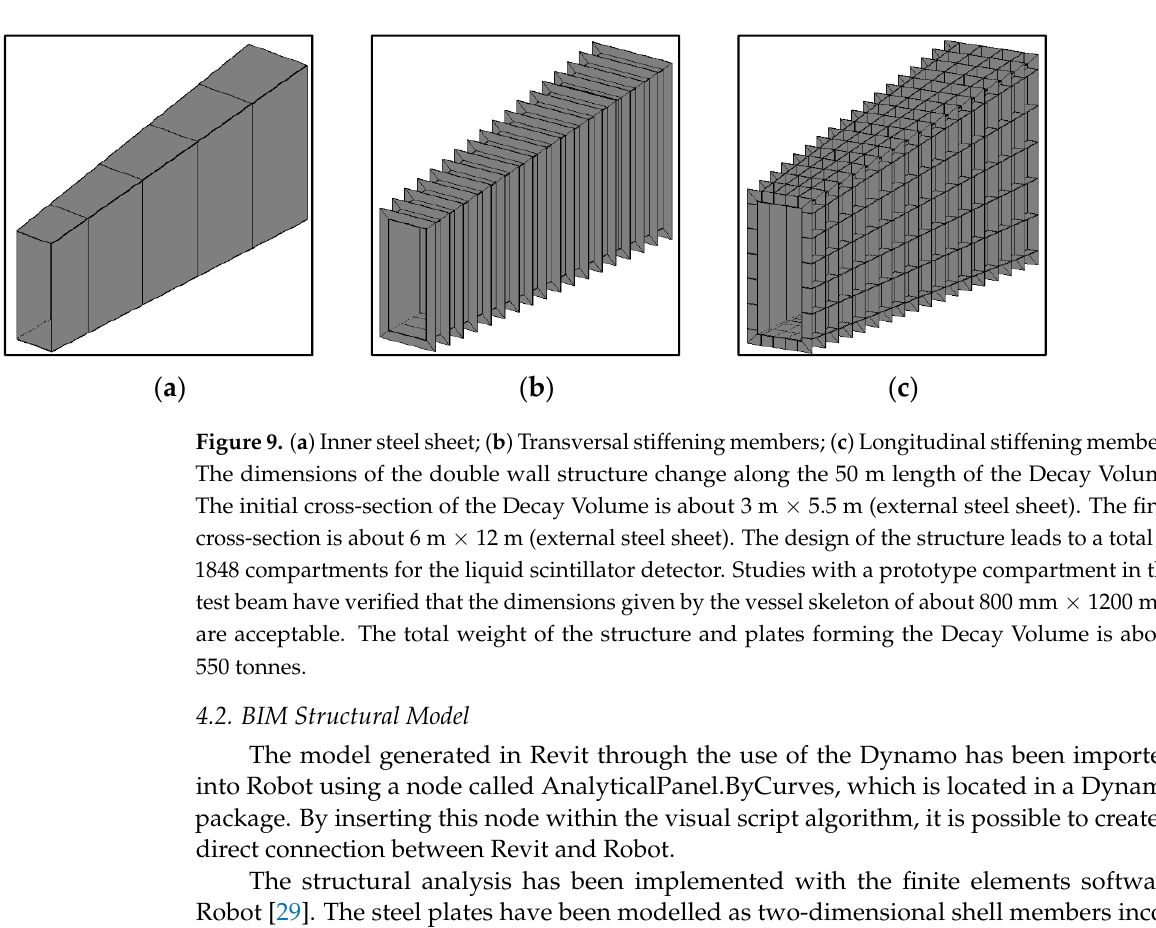
( a ) ( b ) Figure 11. External steel sheet stress path: ( a ) UC σ x; ( b ) UC σ y. ( a ) ( b ) Figure 12. Transversal stiffening members stress path: ( a ) UC σ x; ( b ) UC σ y. ( a ) ( b )